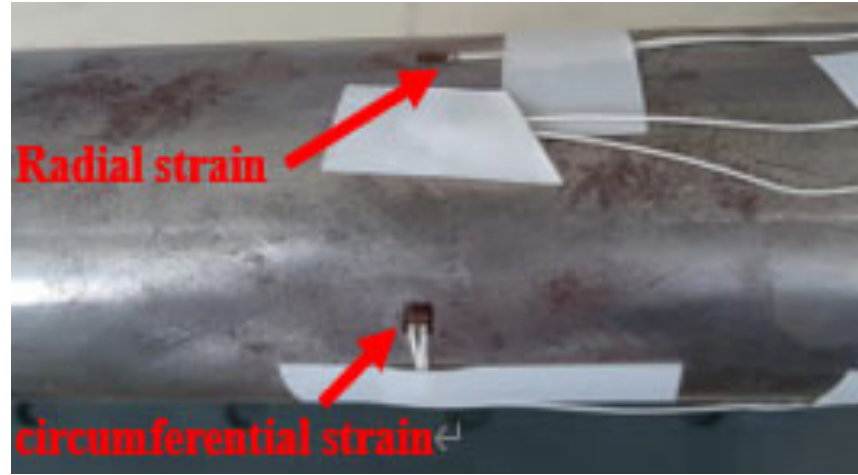
Figure 4. Schematic diagram of pasting radial and circumferential strain gauges. (3) Connect the strain gauge data acquisition line, bridge box (1/4 bridge), super dynamic strain gauge channel and dynamic test system, and open the test system for preheating; (4) Turn on the power control system, fix the distance between the shell and the gas escape port in the gun barrel at 80 mm, the nitrogen pressure in the given pressure chamber of 0.21 MPa, and obtain a relatively standard stability of half-sine incident waveform by fine-tuning the spatial position of the shell, the incident rod and the transmission rod and the parameters of the dynamic acquisition